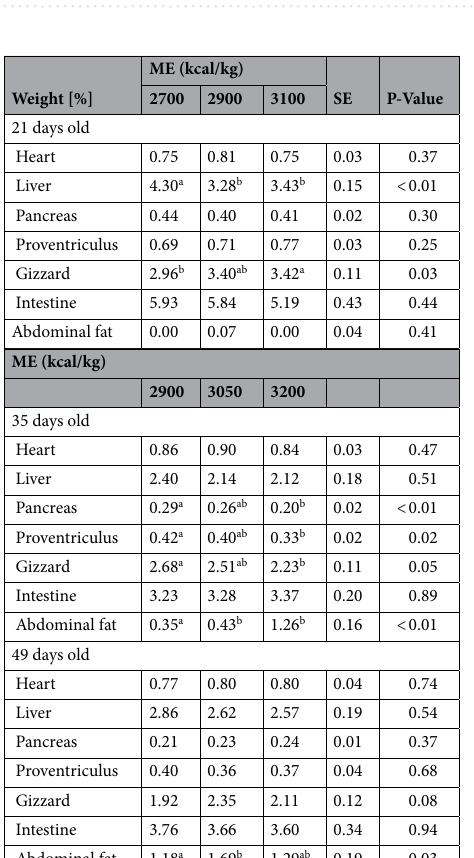
Table 2. Prediction equations to determine the area, width and depth of the M. pectoralis major as a function of quail age and metabolizable energy levels in the diets.